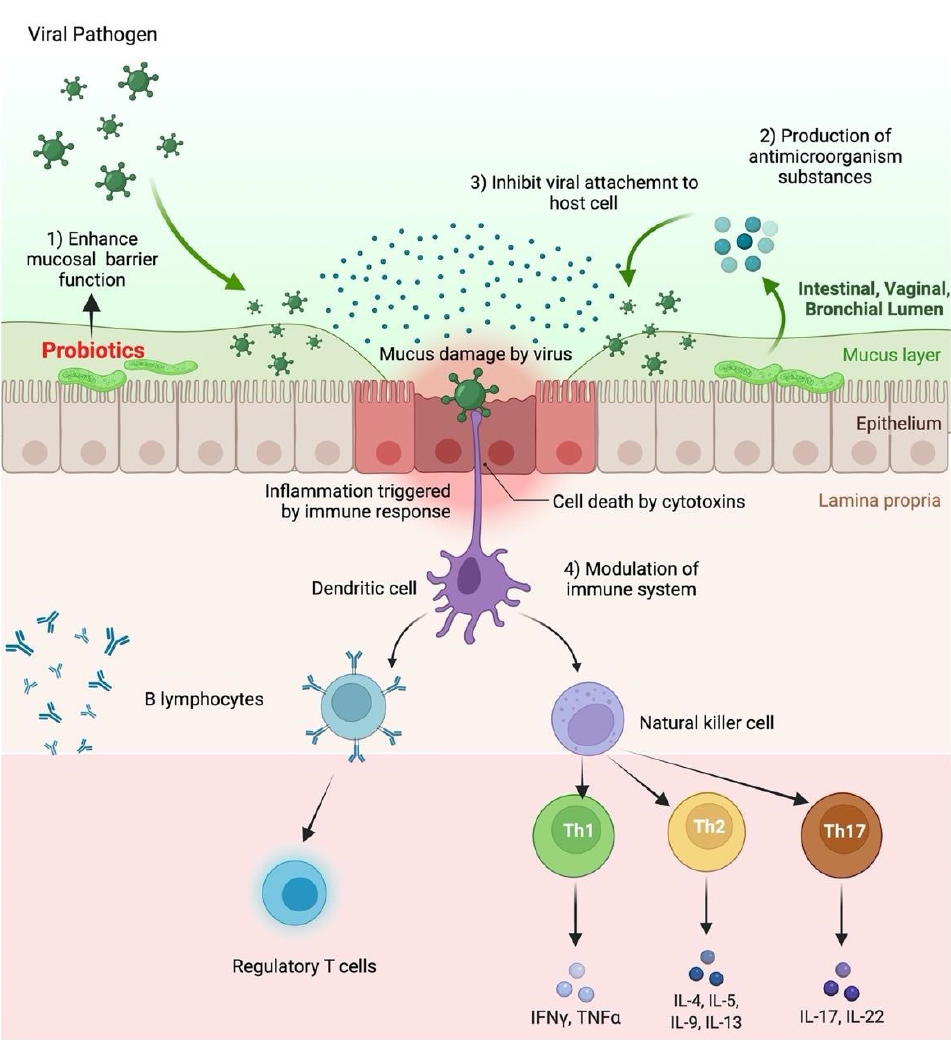
Figure 2. Probable antiviral mechanism of action of probiotics.